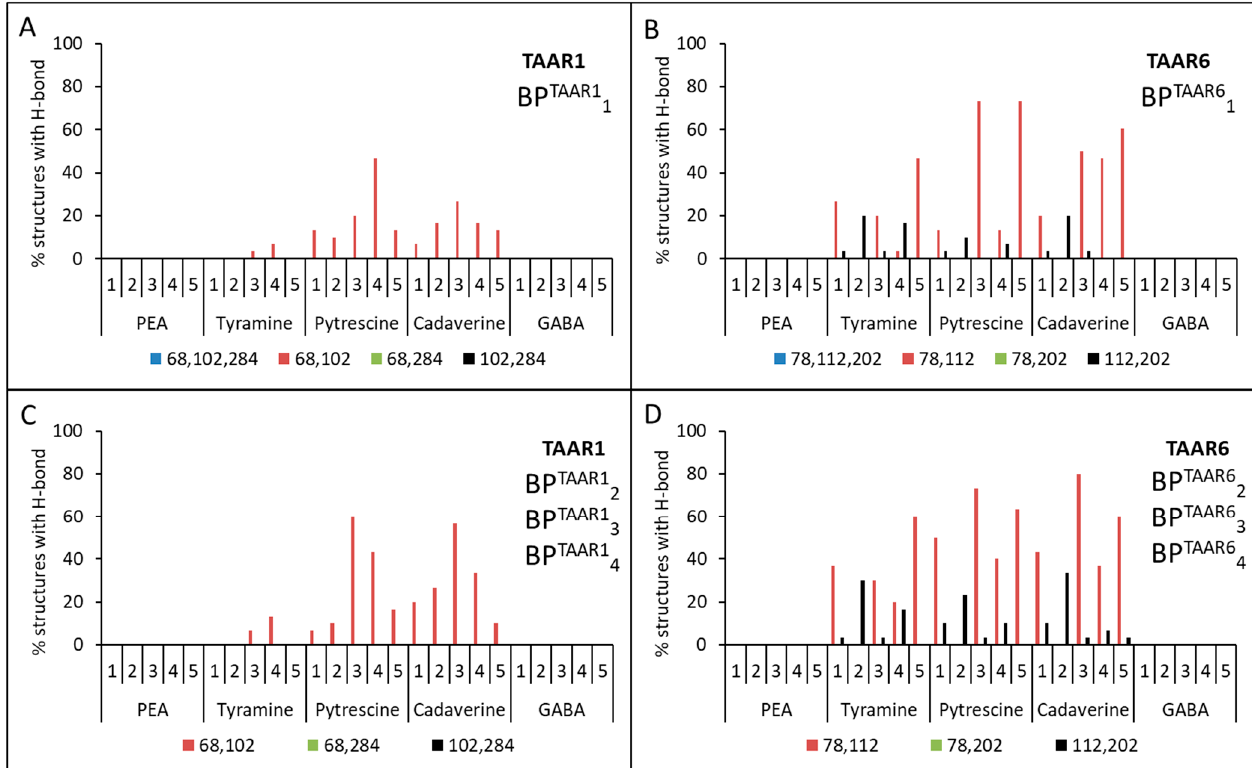
Figure 4. Percentage of structures in which the formation of two hydrogen bonds is observed simultaneously between ligands and the corresponding aspartic amino acids of the receptors. A series of computational experiments when triplets BP TAAR11 and BP TAAR61 ( A , B ) and pairs of aspartic amino acids, BP TAAR12 , BP TAAR13 , BP TAAR14 ( C ) and BP TAAR62 , BP TAAR63 , BP TAAR64 ( D ), were included in the binding pocket.